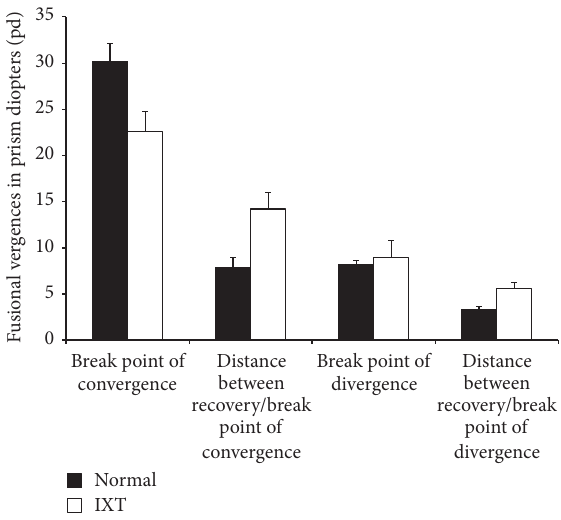
Figure 2: Comparison of fusional vergence detected using a synoptophore between patients with IXT and normal subjects. The mean convergence amplitudes were significantly lower for children withIXTcomparedwithnormalchildren(22.62 ± 2.15versus30.19 ± 1.95 pd, 𝑃 = 0.01 ). No significant difference was observed in the divergence amplitude between children with IXT and normal children (8.98 ± 1.82 versus 8.15 ± 0.44 pd, 𝑃 = 0.53 ). The distance between recovery and break points for both convergence and divergence was larger for patients with IXT compared with normal controls (convergence: 14.18 ± 1.79 versus 7.89 ± 1.09 pd, 𝑃 = 0.005 ; divergence: 5.56 ± 0.71 versus 3.36 ± 0.28 pd, 𝑃 = 0.006